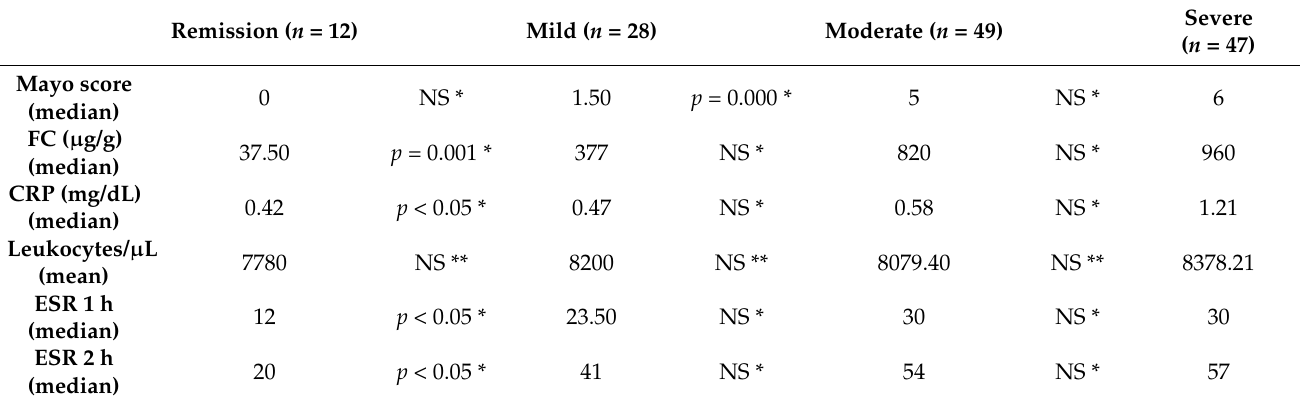
Table 4. Description of non-invasive parameters, according to the degree of endoscopic activity, in patients with ulcerative